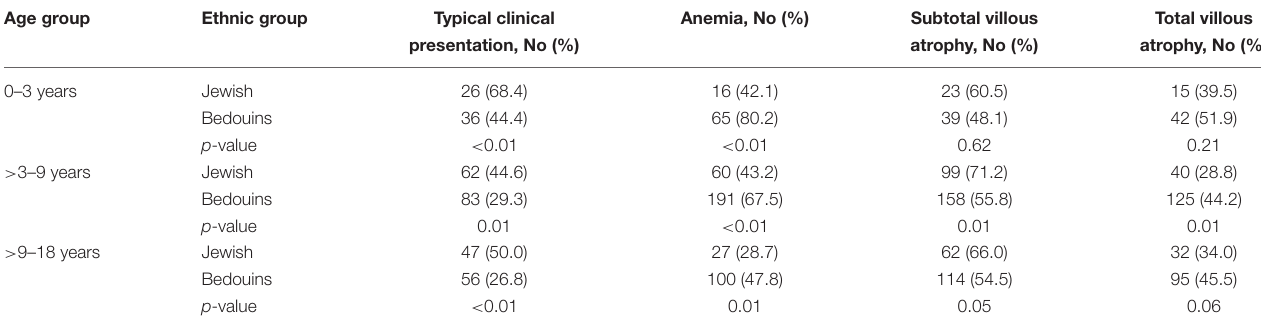
TABLE 3 | Clinical and histological finding by ethnicity and age groups. Age group Ethnic group Typical clinical Anemia, No (%) Subtotal villous Total villous